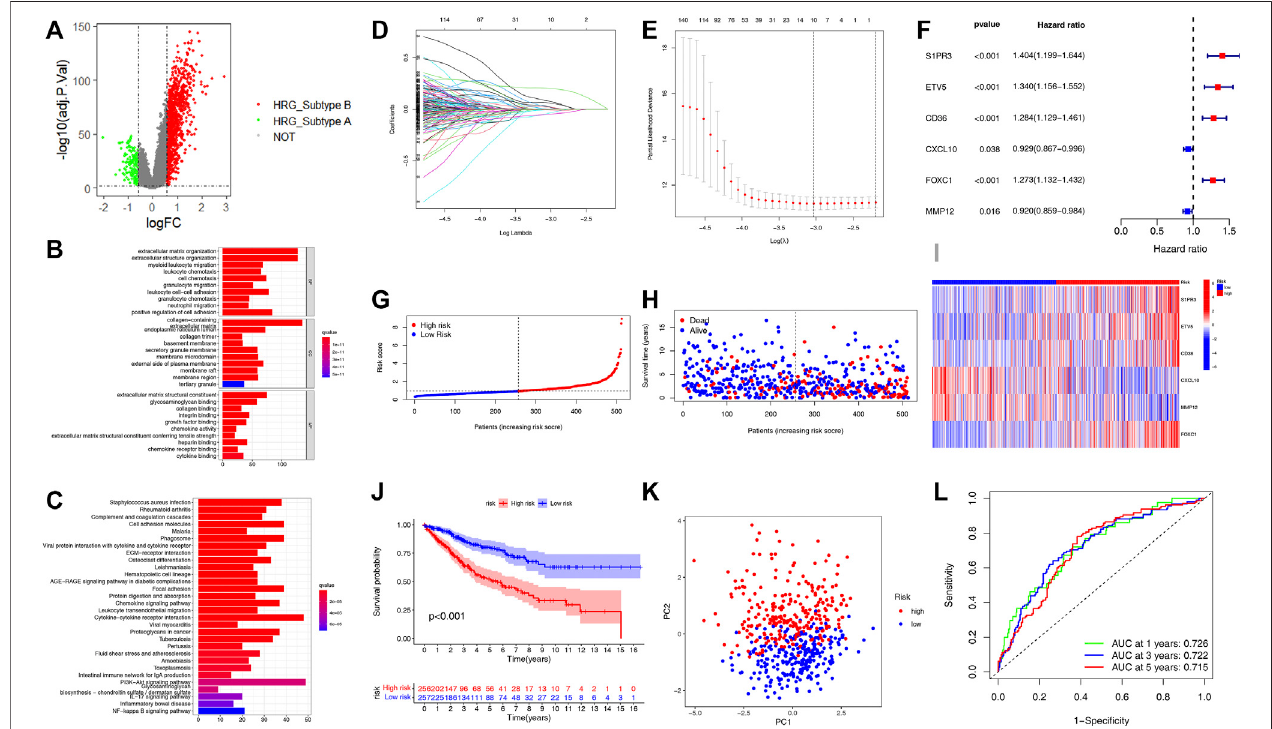
FIGURE 3 | Construction of the HRG-score in the training set based on the differentially expressed genes of two distinct HRG-subtypes. (A) Volcano plot of differentially expressed genes between the two distinct HRG-subtype. Gray dots represent not signi fi cant genes, green dots represent upregulated genes in HRG- subtypeA,and red dots represent upregulatedgenesinHRG-subtypeB (B – C) GOandKEGG enrichmentanalysesofDEGs amongtwodistinctHRG-subtypes. (D – E) LASSO regression analysis and partial likelihood deviance on the prognostic genes. (F) Forest plot of multivariate cox regression analysis for prognostic genes. (G – H) RankeddotandscatterplotsshowingtheHRG-scoredistributionandpatientsurvivalstatus. (I) HeatmapoftheexpressionofsixgenesinvolvedintheHRG-score in low- and high-risk groups. (J) Survival analysis of the patients in low- and high-risk groups. (K) PCA based on the prognostic signature. (L) ROC curves to predict the sensitivity and speci fi city of 1-, 3-, and 5-year survival according to the HRG-score.